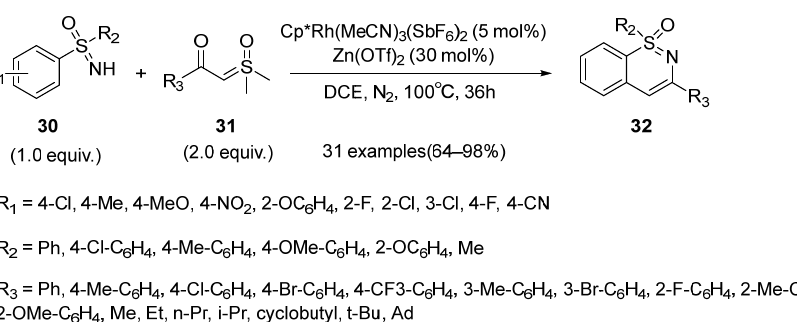
Molecules 2023 , 28 , x FOR PEER